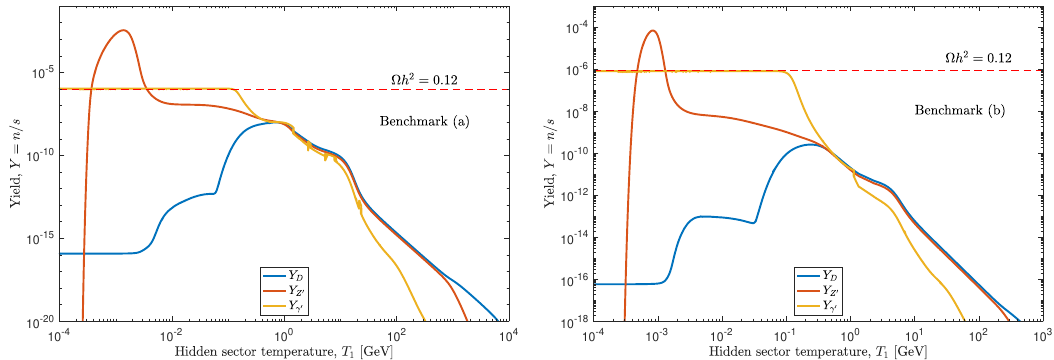
Figure 3 . The yields for the dark fermion D and the dark bosons Z 0 and γ 0 as a function of the hidden sector temperature T 1 for benchmarks (a) (upper panel) and (b) (bottom panel). The horizontal dashed line corresponds to the observed relic density which matches the freeze-out yield of γ 0 . Note that at dark freeze-out Y D (cid:28) Y γ 0 .